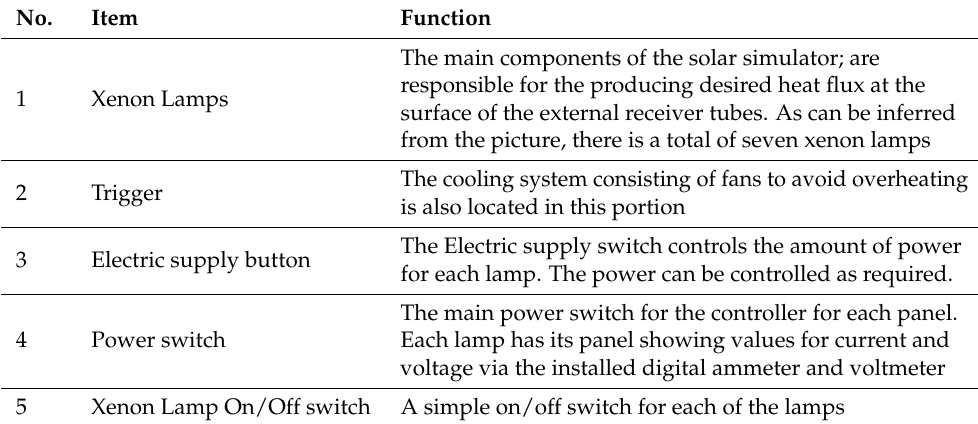
Figure 3. ( a )Thermocouples distribution ( b ) The Solar simulator. Table 2. Components of the solar simulator.